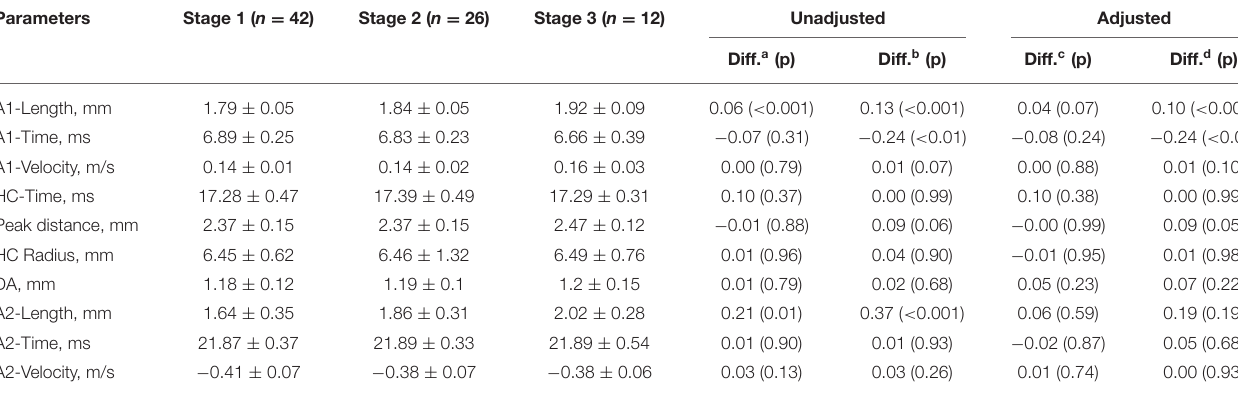
TABLE 4 | Corneal biomechanical properties measured by Corvis ST.